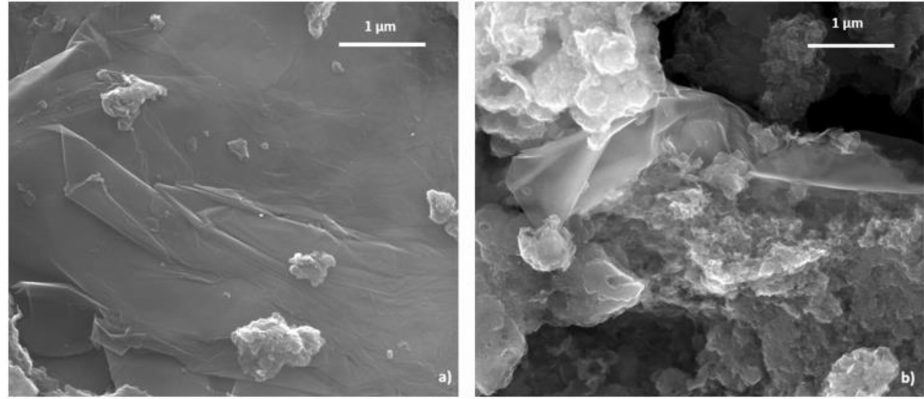
Figure 5. SEM images of GF_ND8 ( a ) and GF_ND8_Co4 ( b ) at 50,000 × g magnification. To ensure that the observed aggregates corresponded to POM clusters, the backscat- tered electron (BSED) mode with elemental mapping was used (Figure 6), as it gives elemental information, since it is based on the atomic number Z [55]. In BSED, the brighter sites represent a higher concentration of elements with a high atomic number, in this case tungsten, and it corresponds well with the mapping images. It can also be noticed that the distribution of tungsten (POM) is heterogeneous throughout the sample. The elements Co and P were not able to be mapped for the same time of acquisition as W due to their lower concentration in the